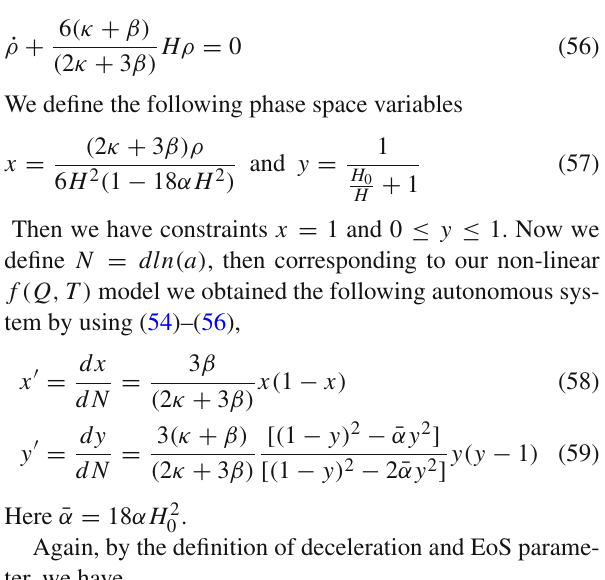
Then we have constraints x + z = 1 and 0 ≤ y ≤ 1.